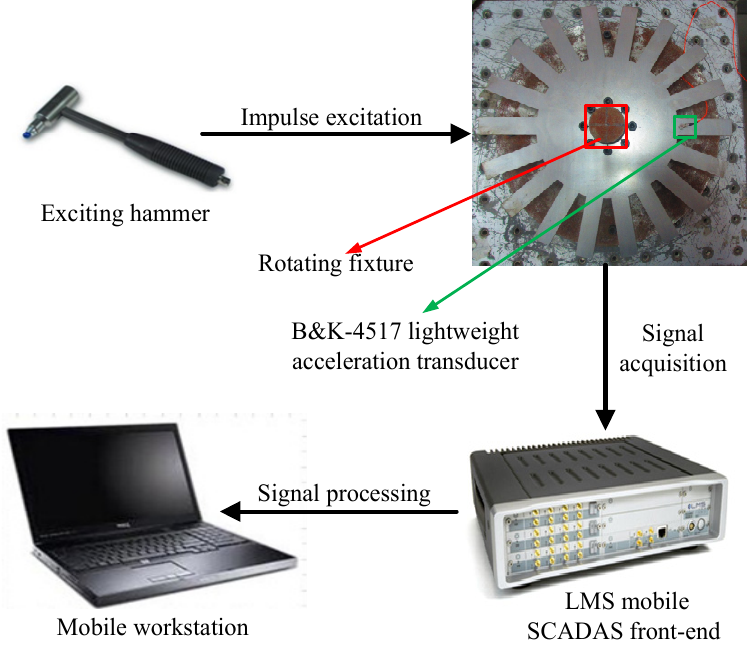
Figure 3. The stainless ‐ steel blisk and experimental devices.